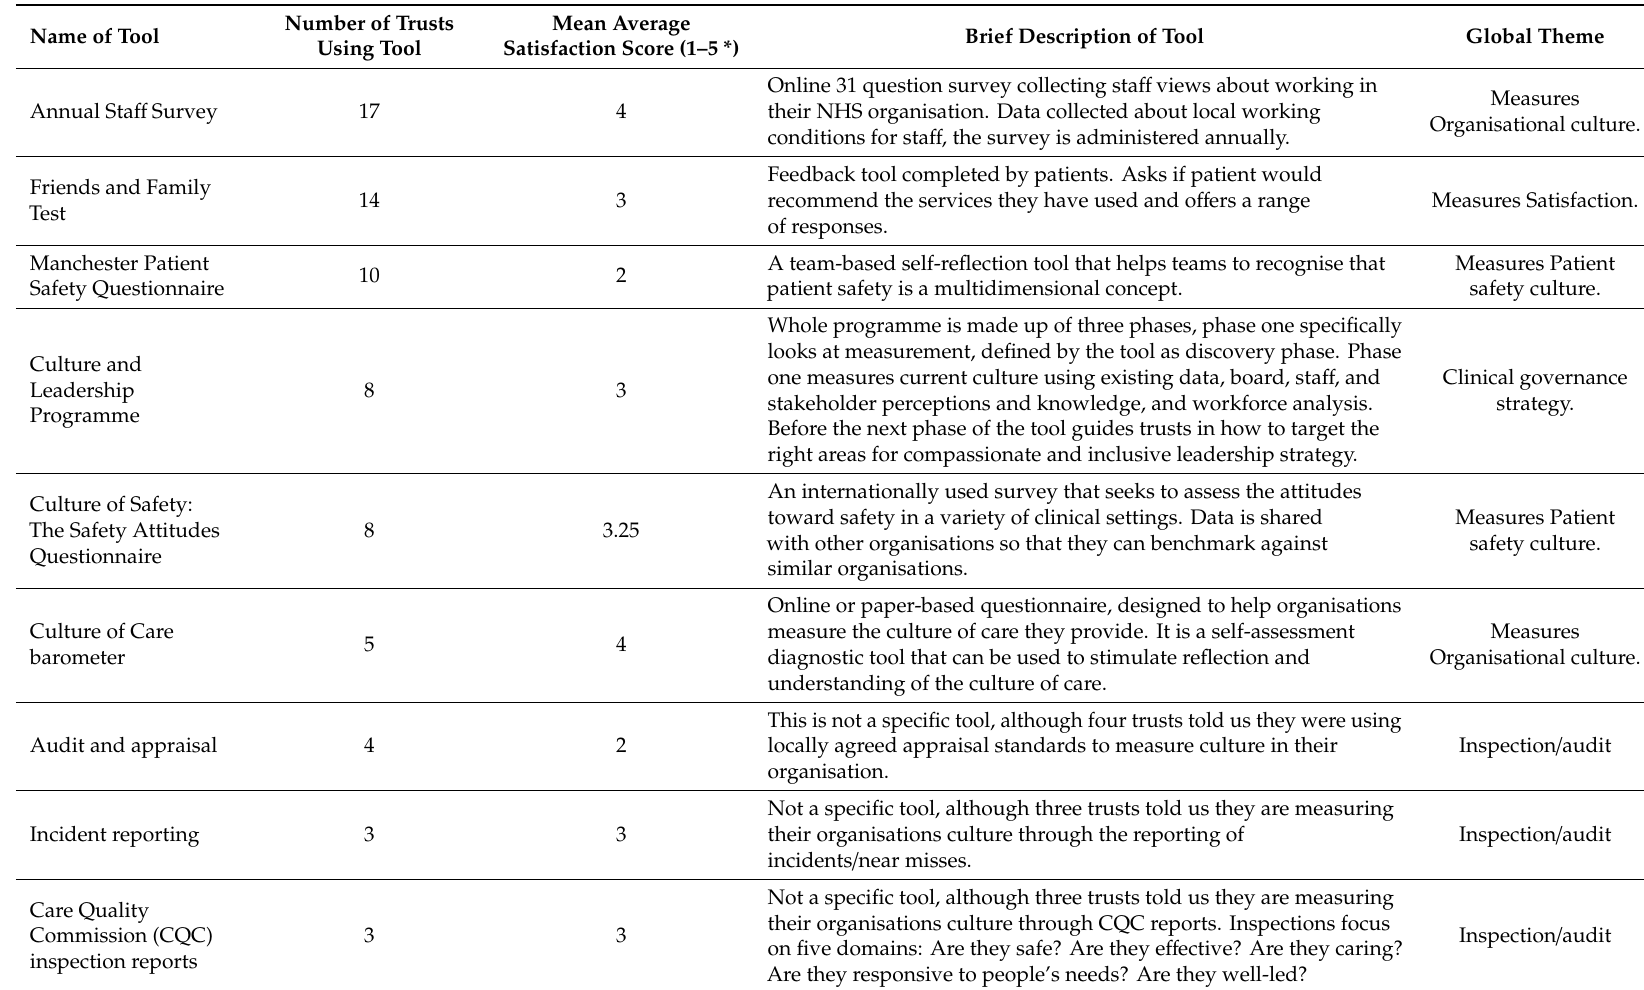
Table 1. Tools currently in use by